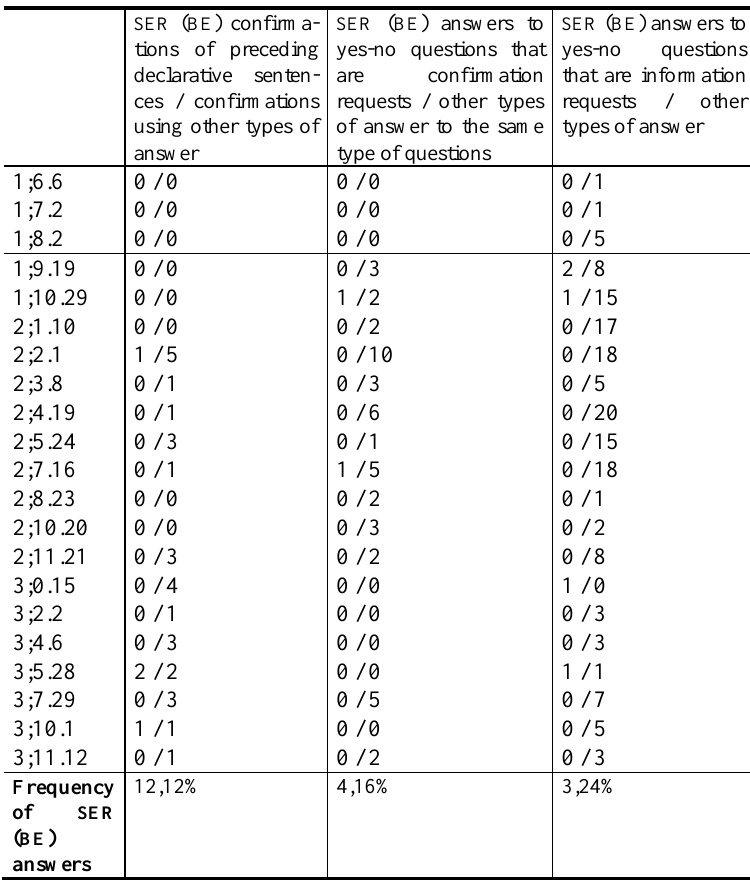
Table IV. Occurrences of SER ( BE ) answers in confirmation and other contexts in Inês’